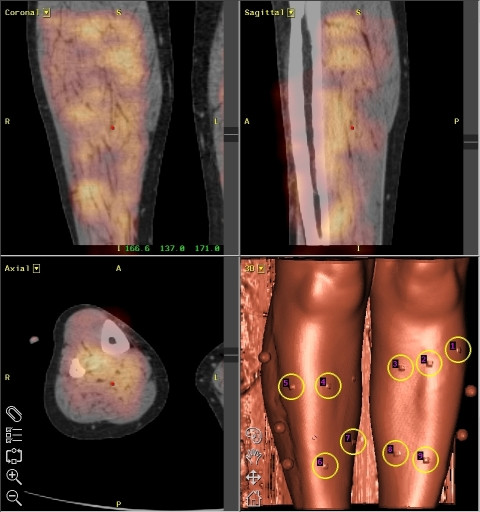
Image fusion of CT and scintigraphic data showing diffuse Octreotide uptake in the lower limbs of a patient with TAO. Octreotide uptake represents inflammatory activity. Taken from [49]. Each reconstruction plane is labeled in the upper left corner of the image. The right lower image is an anatomical reconstruction of the surface of the leg.